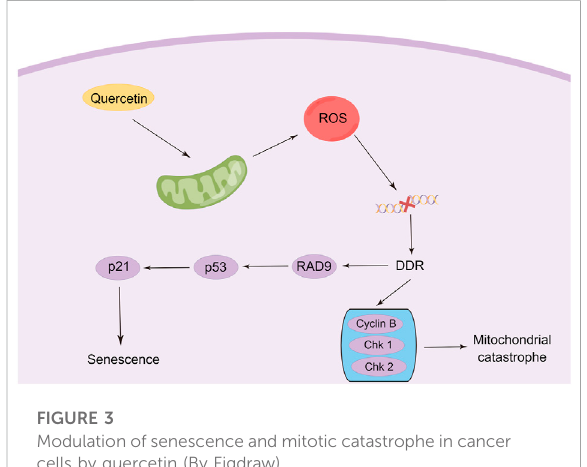
FIGURE 3 Modulation of senescence and mitotic catastrophe in cancer cells by quercetin (By